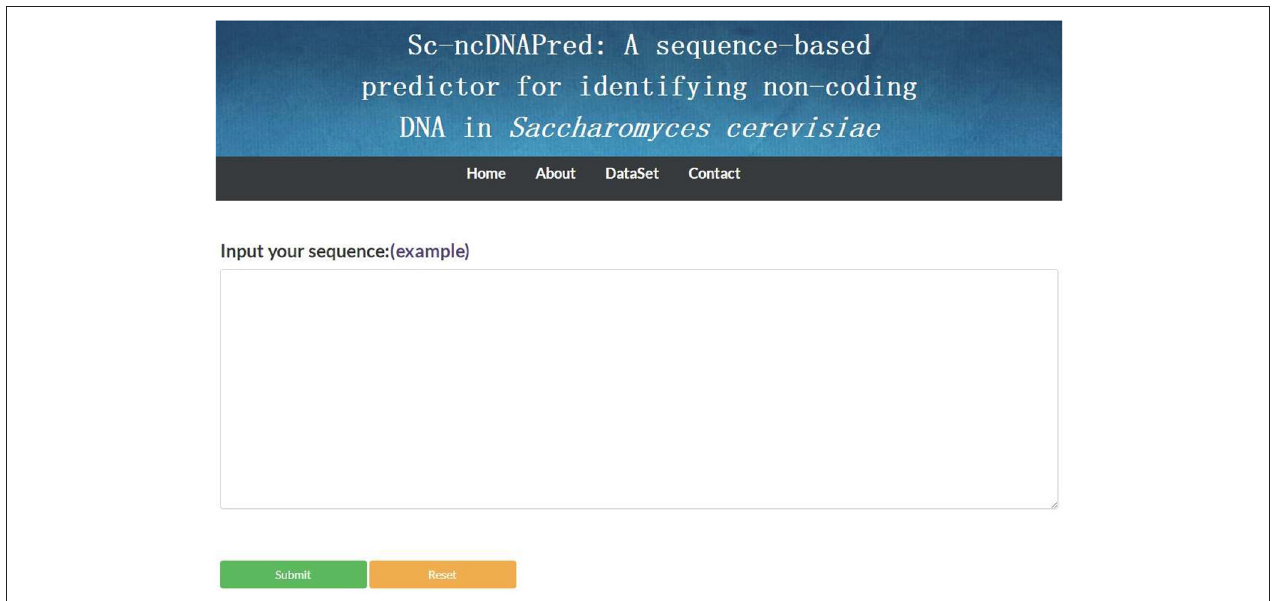
FIGURE 6 | A semi-screenshot of the top page of the Sc-ncDNAPred web-server at: